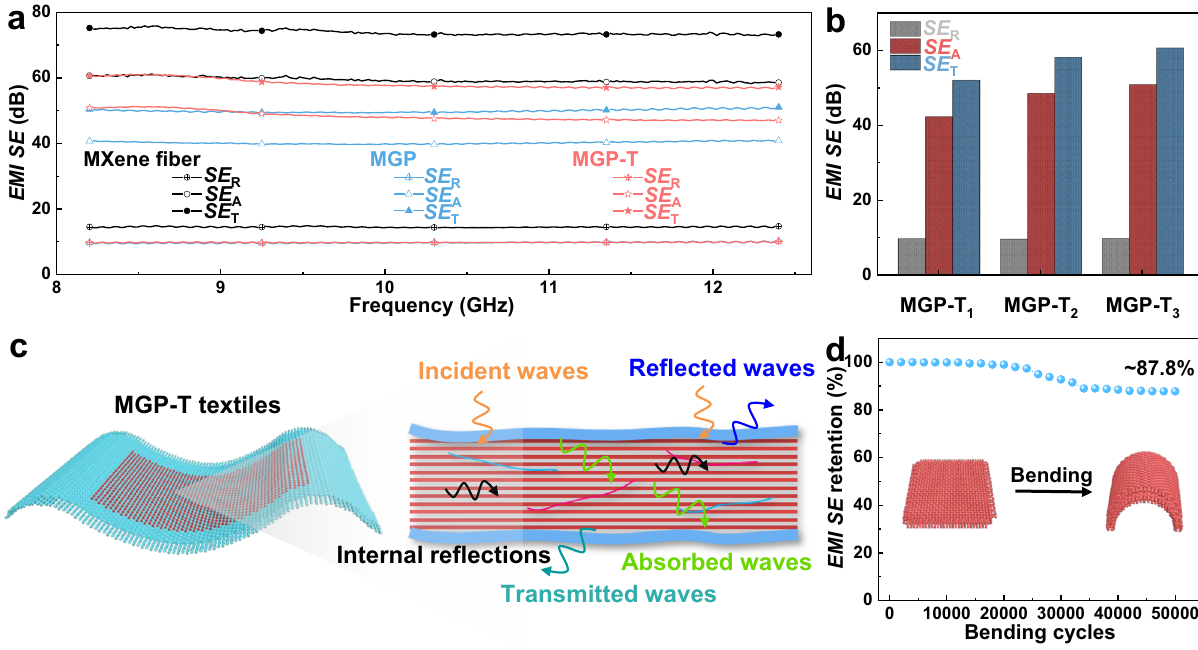
c The EMI mechanism of the MGP-T textiles. d EMI SE retention of textile after 5×10 4 bending